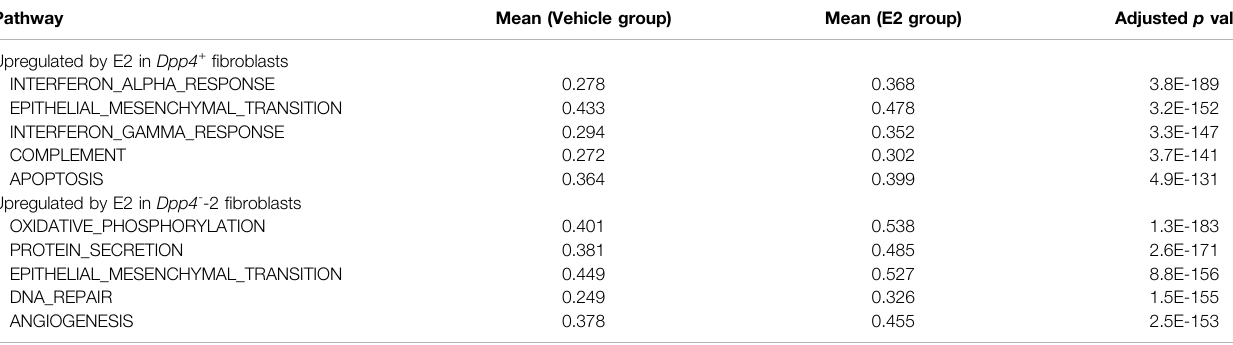
TABLE 2 | Top 5 signi fi cant gene signatures and mean ssGSEA scores upregulated by E2 treatment. Pathway Mean (Vehicle